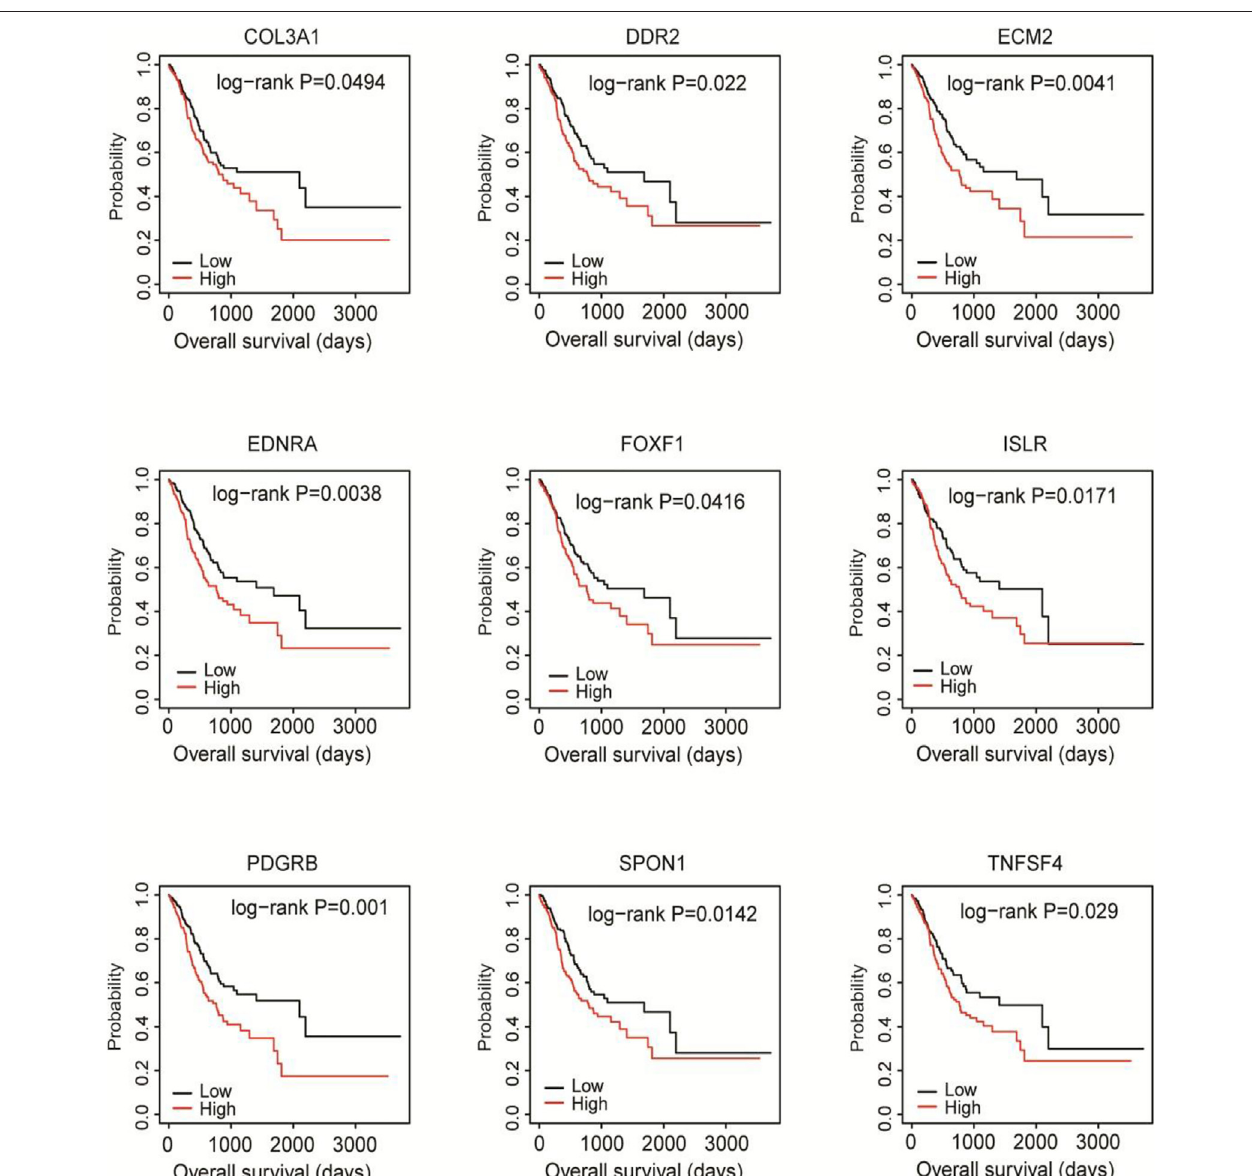
FIGURE 4 | Kaplan-Meier survival analysis of the associations of 9 hub DEGs with the overall survival of the TCGA cohort. Patients were divided into high and low expression groups according to the mean mRNA level of each hub DEG. Kaplan-Meier survival analysis was performed.